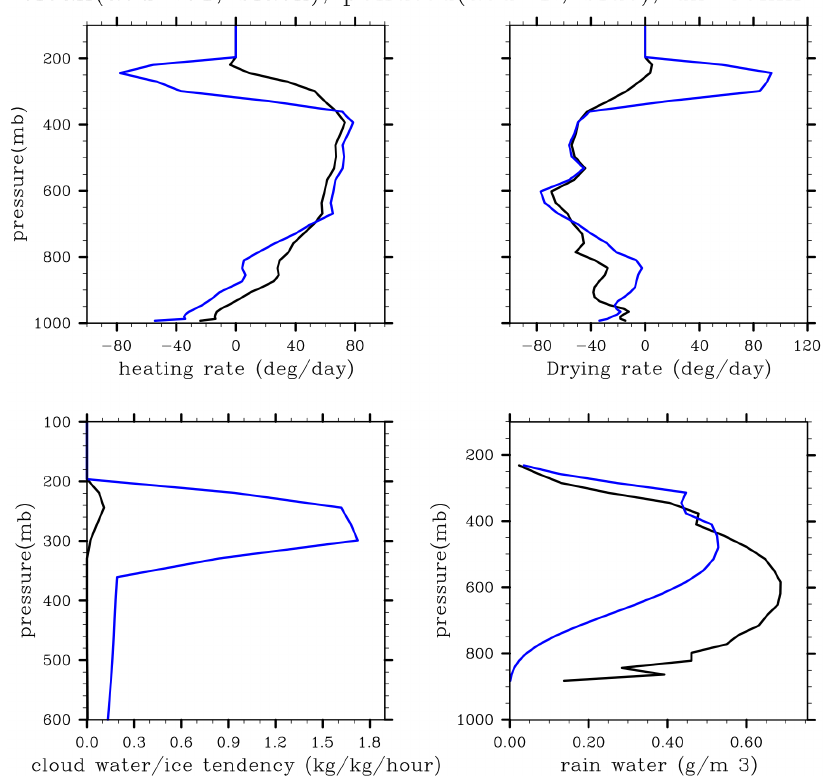
Figure 4. Vertical profiles of heating, drying, cloud water and ice tendencies, and rain water distribution for clean (black) and polluted (blue)